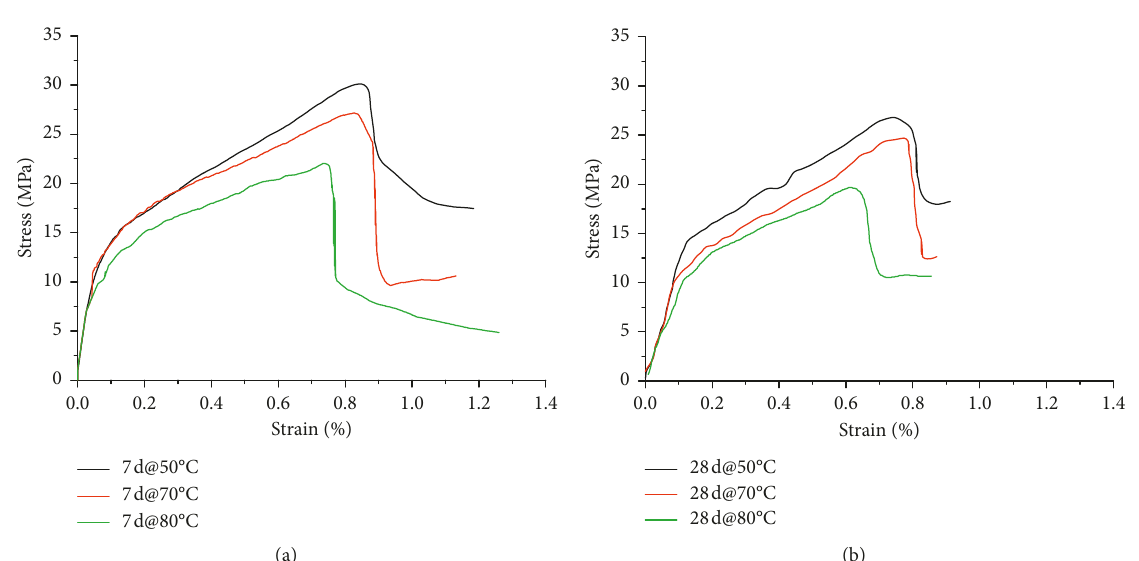
Figure 2: Stress-strain curves of CSA/GFRC cured at different curing regimes. Curing day of (a) 7d and (b)